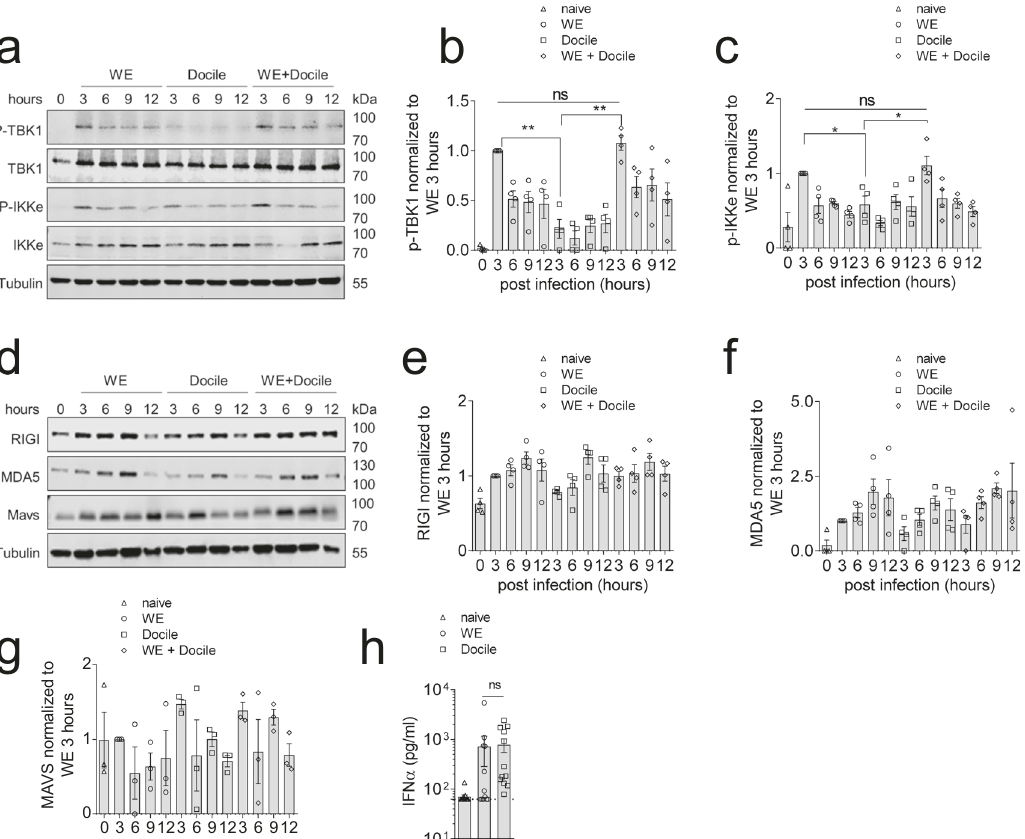
Fig. 4 LCMV-WE strain triggers robust pattern recognition receptor (PRR) activation. GM-CSF induced BMDCs were infected with LCMV-WE, LCMV- Docile, or co-infected at a MOI of 1. a Whole-cell lysates from LCMV infected BMDCs were blotted for p-TBK1, total TBK1, p-IKK ε , total IKK ε , and loading control α -Tubulin (one representative blot of n = 4 is shown, uncropped blots scans in Supplementary Fig. 6). b p-TBK1, c p-IKK ε quanti fi cation was analyzed by fi rst normalizing to the corresponding loading control, followed by standardizing to the 3 h LCMV-WE infected BMDC group ( n = 4). d Whole- cell lysates from infected BMDCs were blotted for RIG-I, MDA5, MAVS, and loading control α -Tubulin at the indicated timepoints post-infection (uncropped blots scans in Supplementary Fig. 8). e RIG-I ( n = 4), f MDA5 ( n = 4), g MAVS ( n = 3) quanti fi cation was analyzed by fi rst normalizing to loading control, followed by standardizing to the 3 h LCMV-WE infected BMDC group. h JAWSII immature DC cells were transfected with 100 ng of LCMV-WE or LCMV-Docile genomic RNA and 24 h post transfection, IFN- α levels were determined in the supernatant of transfected DC cells ( n = 12). (Error bars show SEM, * p < 0.05, ** p < 0.01, and ns indicates statistically not signi fi cant between the indicated